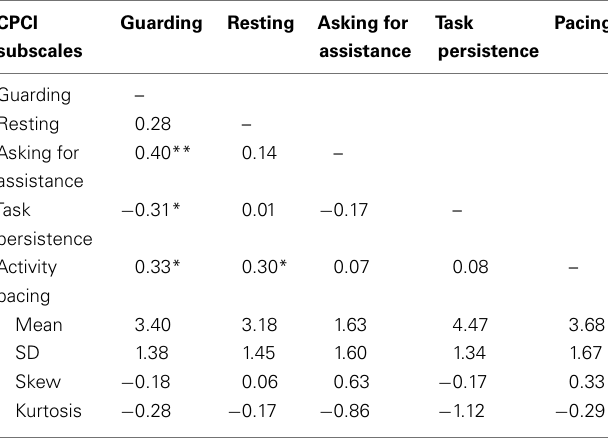
Table 2 | Correlations and distribution statistics for CPCI subscales ( N = 44).